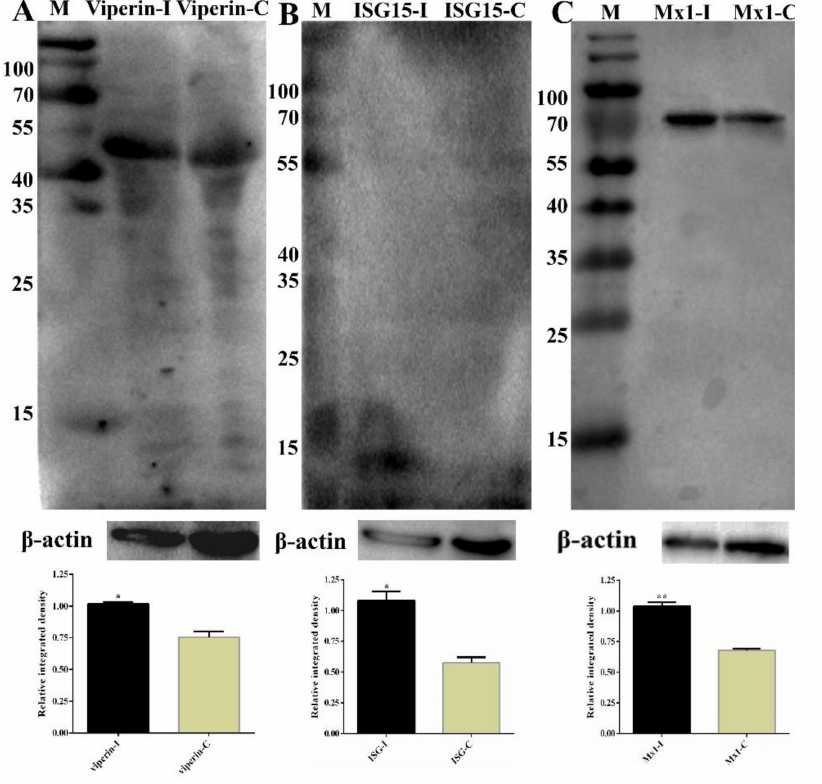
Figure 11. Partial validation of RNA-Sequencing (RNA-Seq) and isobaric tags for relative and absolute quantitation (iTRAQ) data by Western blot. ( A ) The expression of RSAD2 (Viperin) in the samples was determined by Western blot. The molecular weight of Viperin was 42 kDa. Lane M, prestained protein mass markers; Lane 1, CpHV-1-infected MDBK cell sample; Lane 2, mock-infected MDBK cell sample. β -actin was the internal control; molecular weight was 42 kDa. ( B ) ISG15 western blot analysis of MDBK cells. The molecular weight of ISG15 was 15 kDa. Lane M, prestained protein mass markers; Lane 1, CpHV-1-infected MDBK cell sample; Lane 2, mock-infected MDBK cell sample. β -actin was the internal control. ( C ) MX1 western blot analysis of MDBK cells. The molecular weight of MX1 was 74.8 kDa. Lane M, prestained protein mass markers; Lane 1, CpHV-1-infected MDBK cell sample; Lane 2, mock-infected MDBK cell sample. β -actin was the internal control. The integrated density of every group was compared with that of internal loading control β -actin before the relative integrated density values between every infected group and its corresponding control group were calculated. Western strips were performed by grayscale analysis using the ImageJ software, and error bars represent relative integrated density mean standard deviations among three independent replicates. * p < 0.05 and ** p <